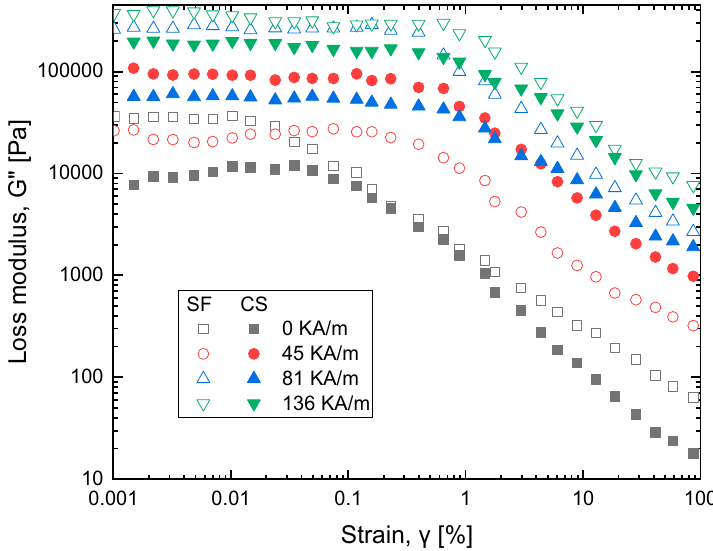
Figure 7. Loss modulus as a function of strain at variable magnetic field strength for sunflower (SF) and cottonseed (CS) blend-based MR fluid.